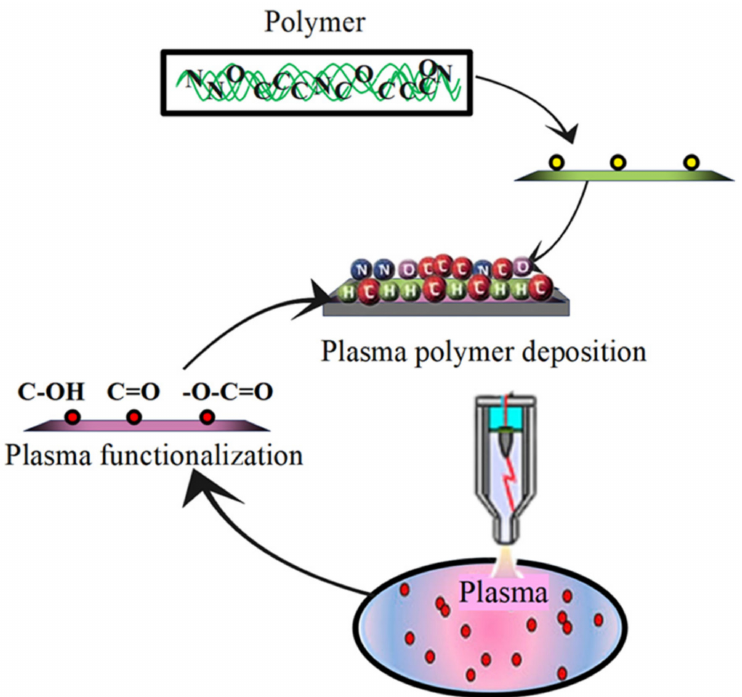
Figure 3. Plasma processing of surface morphology for